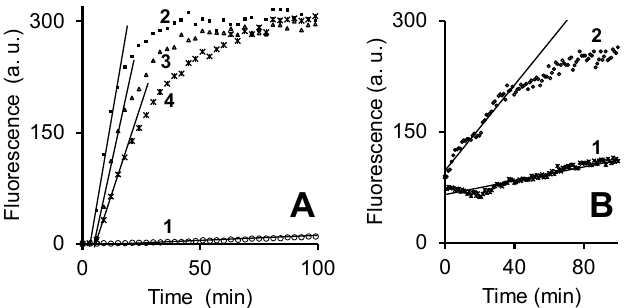
Figure 1. A : Increase of fluorescence ( λ ex = 501 nm, λ em = 525 nm) of solutions containing a mixture of 2 ′ ,7 ′ -dichlorofluorescin (10 μ M), 3-(N-morpholino)propanesulfonic acid (MOPS, 100 mM, pH 7.5), N , N , N ′ , N ′ -ethylenediaminetetracetic acid (EDTA, 10 mM), glutathione (GSH, 5 mM), H 2 O 2 (10 mM, curve 1, negative control) and either FeSO 4 (49.5 μ M, curve 2, positive control) or prodrug 8 (49.5 μ M, curve 3) or prodrug 5 (49.5 μ M, curve 4) ; (dF/dt) 0 = 22.3, 17.1, 7.7 and 0.1 a.u.·min − 1 ; temperature = 37 °C. B : Increase of fluorescence ( λ ex = 551 nm, λ em = 576 nm) of solutions containing a mixture of prodrug 7 (0.5 μ M), phosphate-buffered saline (10 mM phosphate, 150 mM NaCl, pH 7) and either without (curve 1, negative control) or with H 2 O 2 (50 mM, curve 2). (dF/dt) 0 = 0.5 (curve 1), 2.9 (curve 2) a.u.·min − 1 .